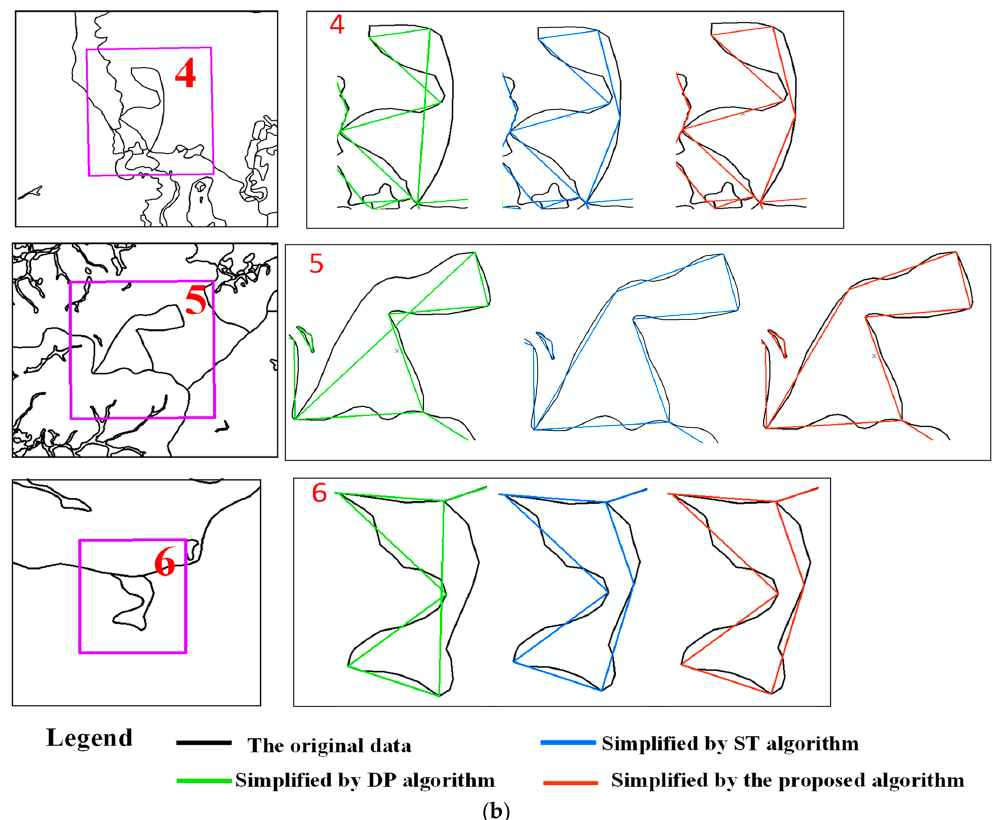
Figure 4. The six simplified results of the three applied methods from the two groups of data. ( a ) The three self-intersection problems identified from the first group of data; ( b ) the three self-intersection problems identified from the second group of data. Notes: DP algorithm is the Douglas–Peucker algorithm proposed by Douglas and Peucker [1]; ST algorithm is the star-shaped algorithm proposed by Wu and Marquez [23].